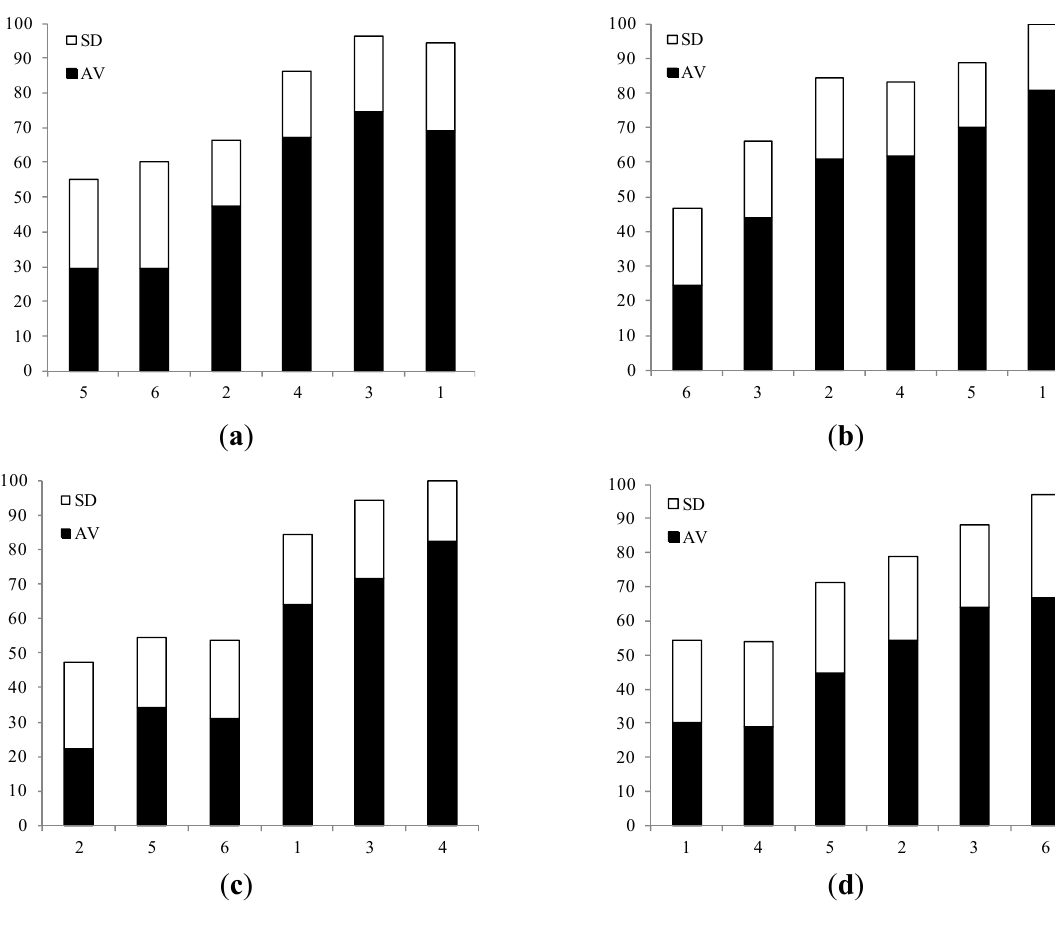
Figure 4. Stage 3 estimations (%) by the general public for the variables ( a ) aesthetics ; ( b ) land cost ; ( c ) habitat for species ; and ( d ) safety. based on different pictures represented by numbers on the x-axis. SD, standard deviation; AV,